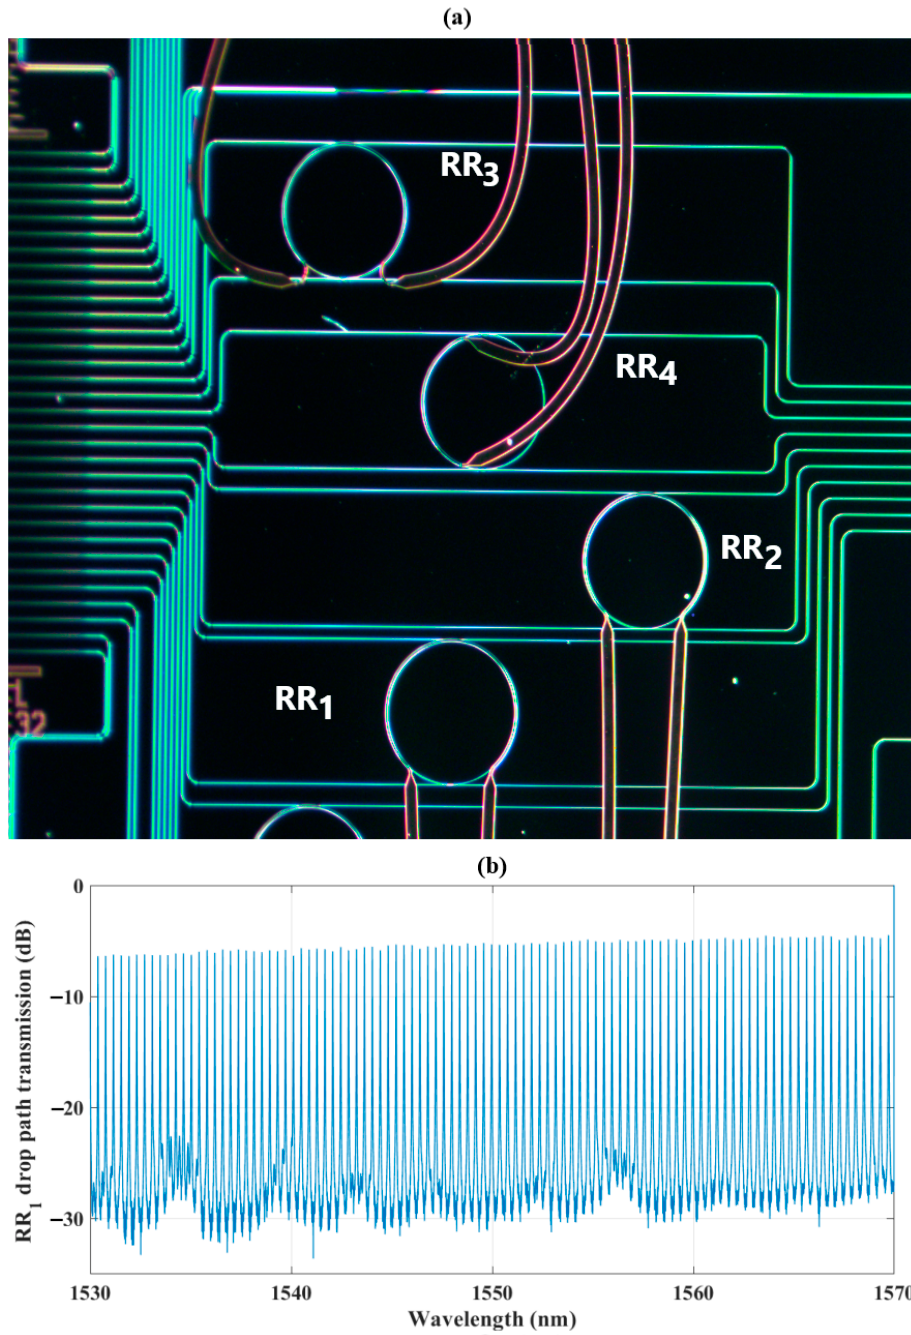
Figure 3. ( a ) Micrograph of different ring resonators. Each RR has the same radius, but different gaps. The minimum gaps of the ring waveguide and access waveguide are 1.2 μ m, 1.5 μ m, and 1.8 μ m for RR 1 , RR 2 , RR 3 , and RR 4 , respectively. All rings are equipped with thermo-optic phase